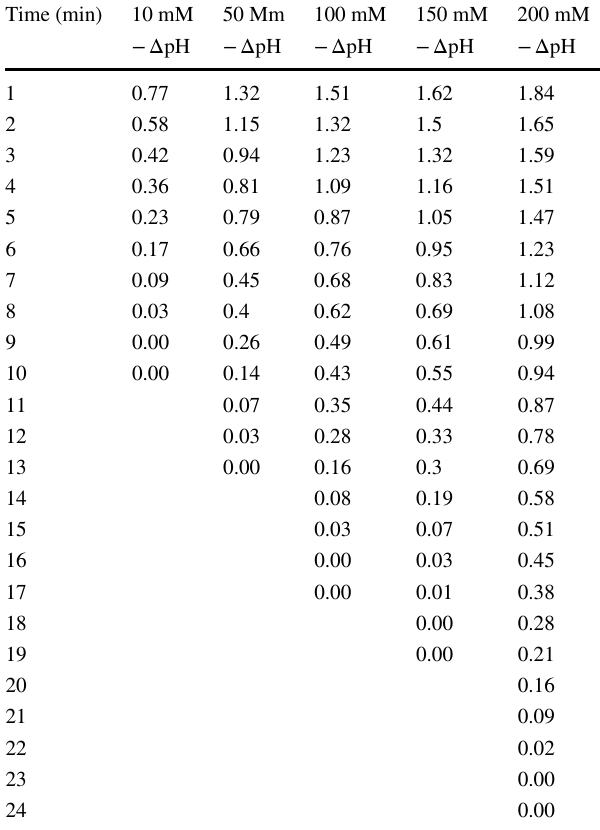
Table 2 pH variation after mixing for aqueous solution containing copper(II)